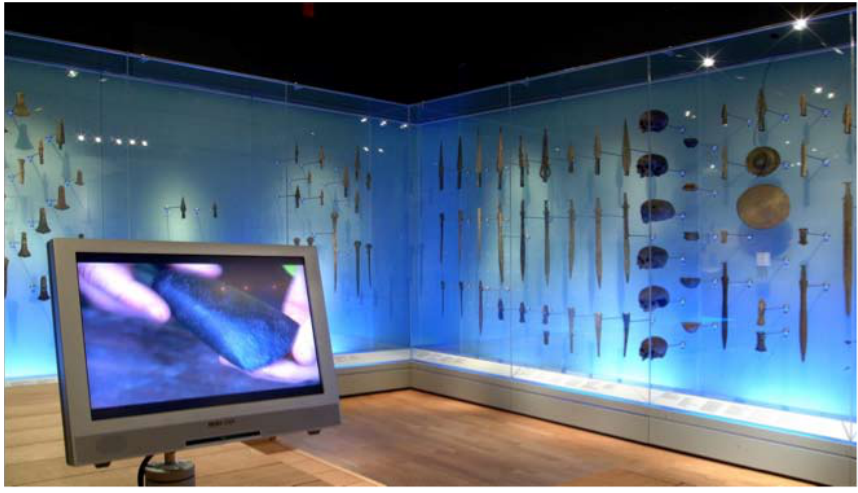
Fig 1. Museum of London: Display case with prehistoric